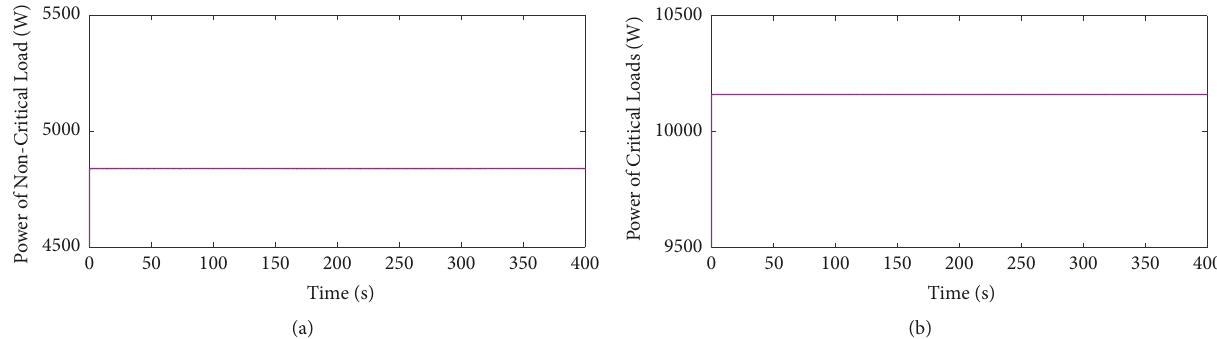
Figure 12: The input power waveform of loads when ES is not activated. (a) Noncritical load. (b) Critical loads.